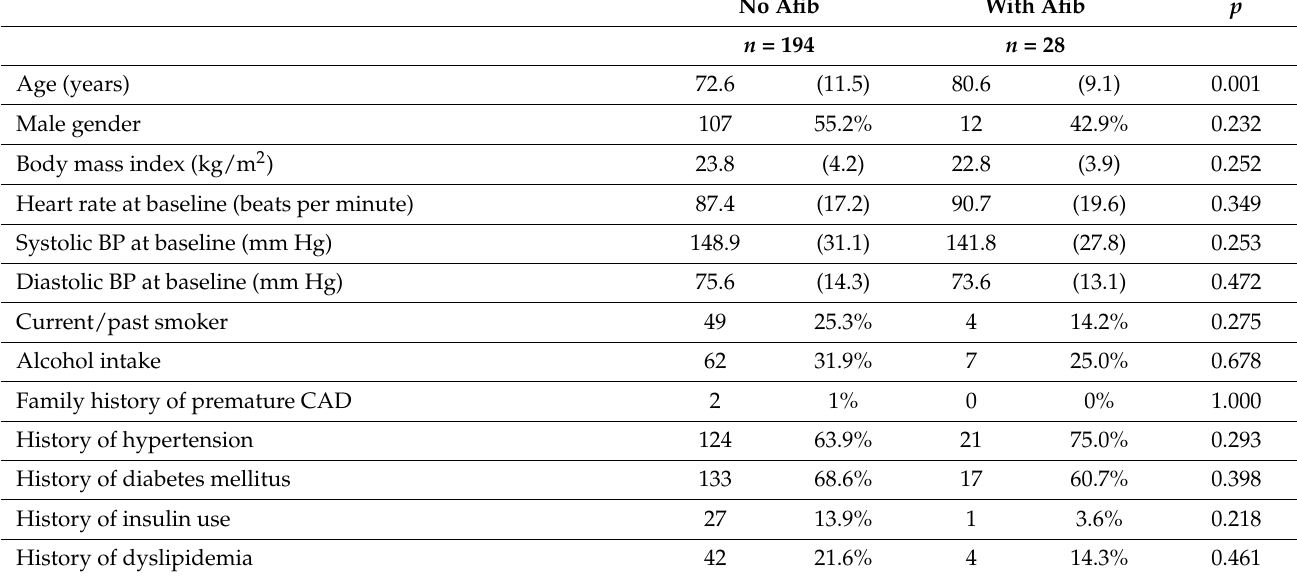
Table 1. Baseline and procedural characteristics and laboratory data in patients with severe lower extremity arterial